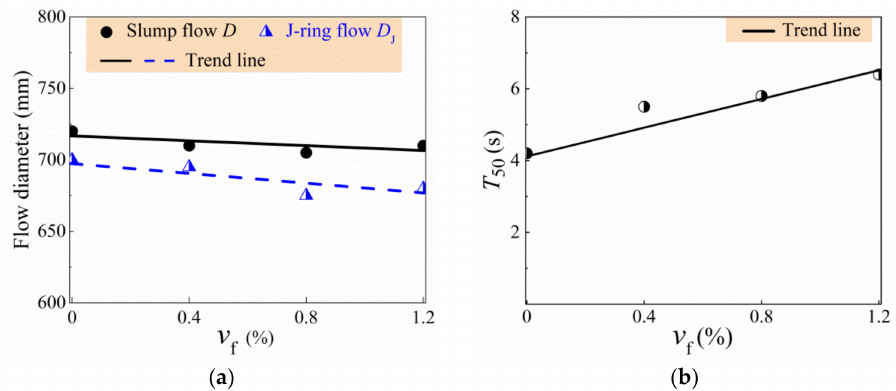
Figure 5. Variations of workability indexes with v f : ( a ) Diameter of slump-flow and J-ring flow; ( b ) T 50 .